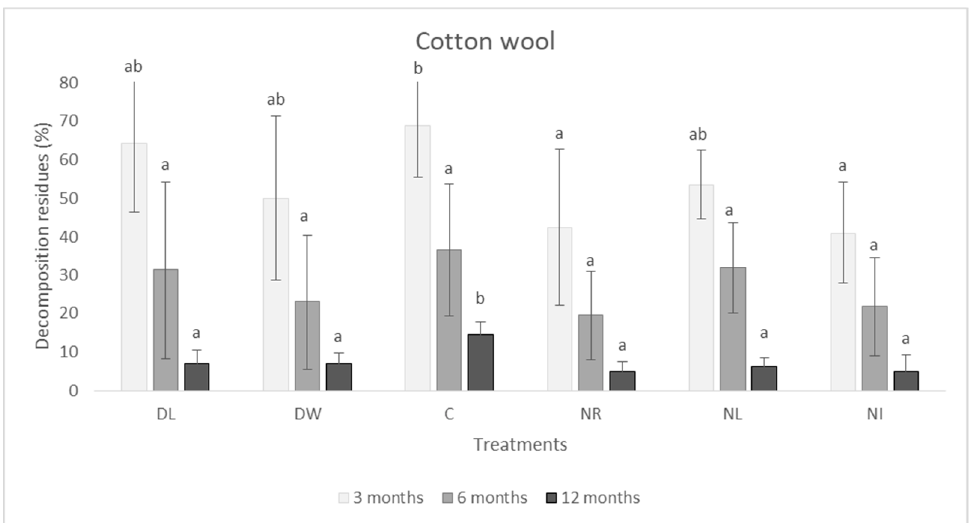
Figure 1. Effect of organic matter manipulation experiments with different DIRT treatments on cotton wool degradation rates after 3, 6 and 12 months: The letters represent significant differences between treatments during the given period ( n = 4).